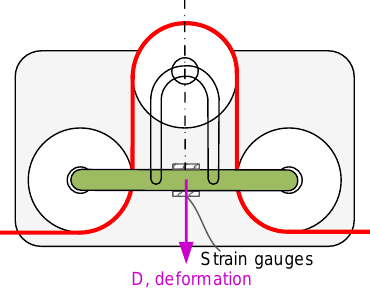
Figure 4. Conceptualization of our proposal.